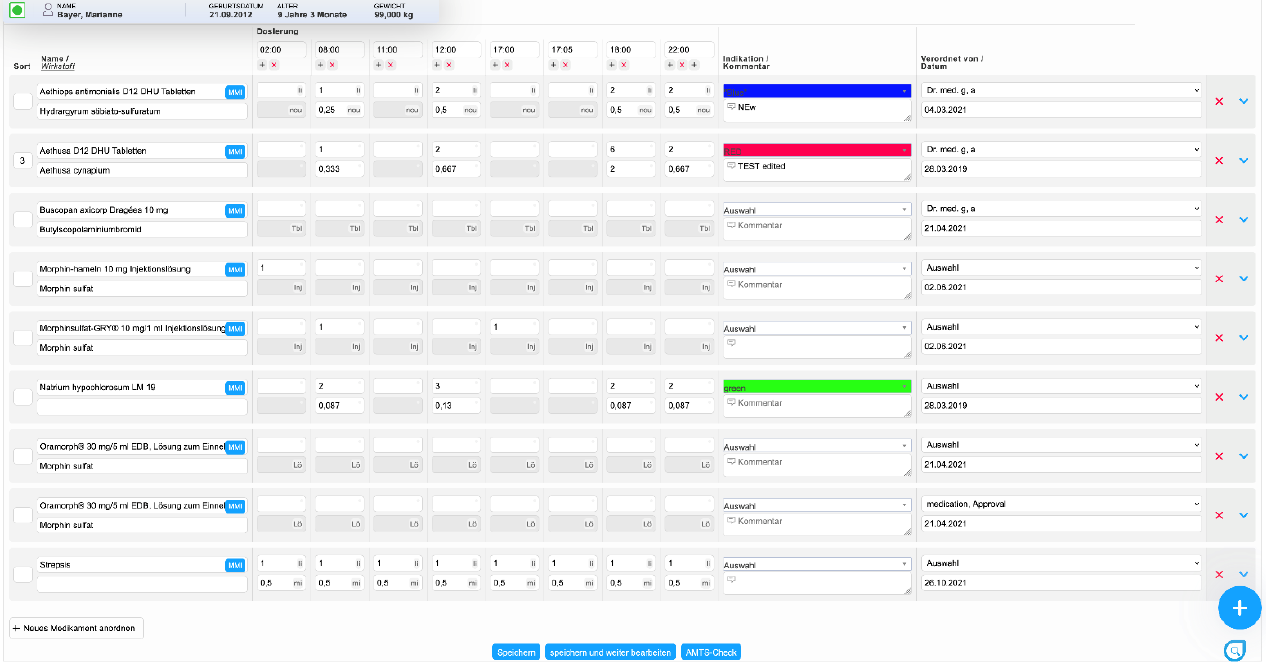
Figure 1. View for the prescription of medications (ISPC/smart-Q).